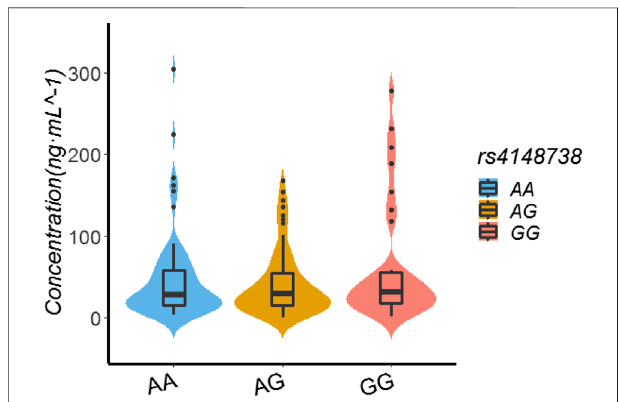
FIGURE 3 | Effect of SNP rs4148738 on Rivaroxaban dose of 155